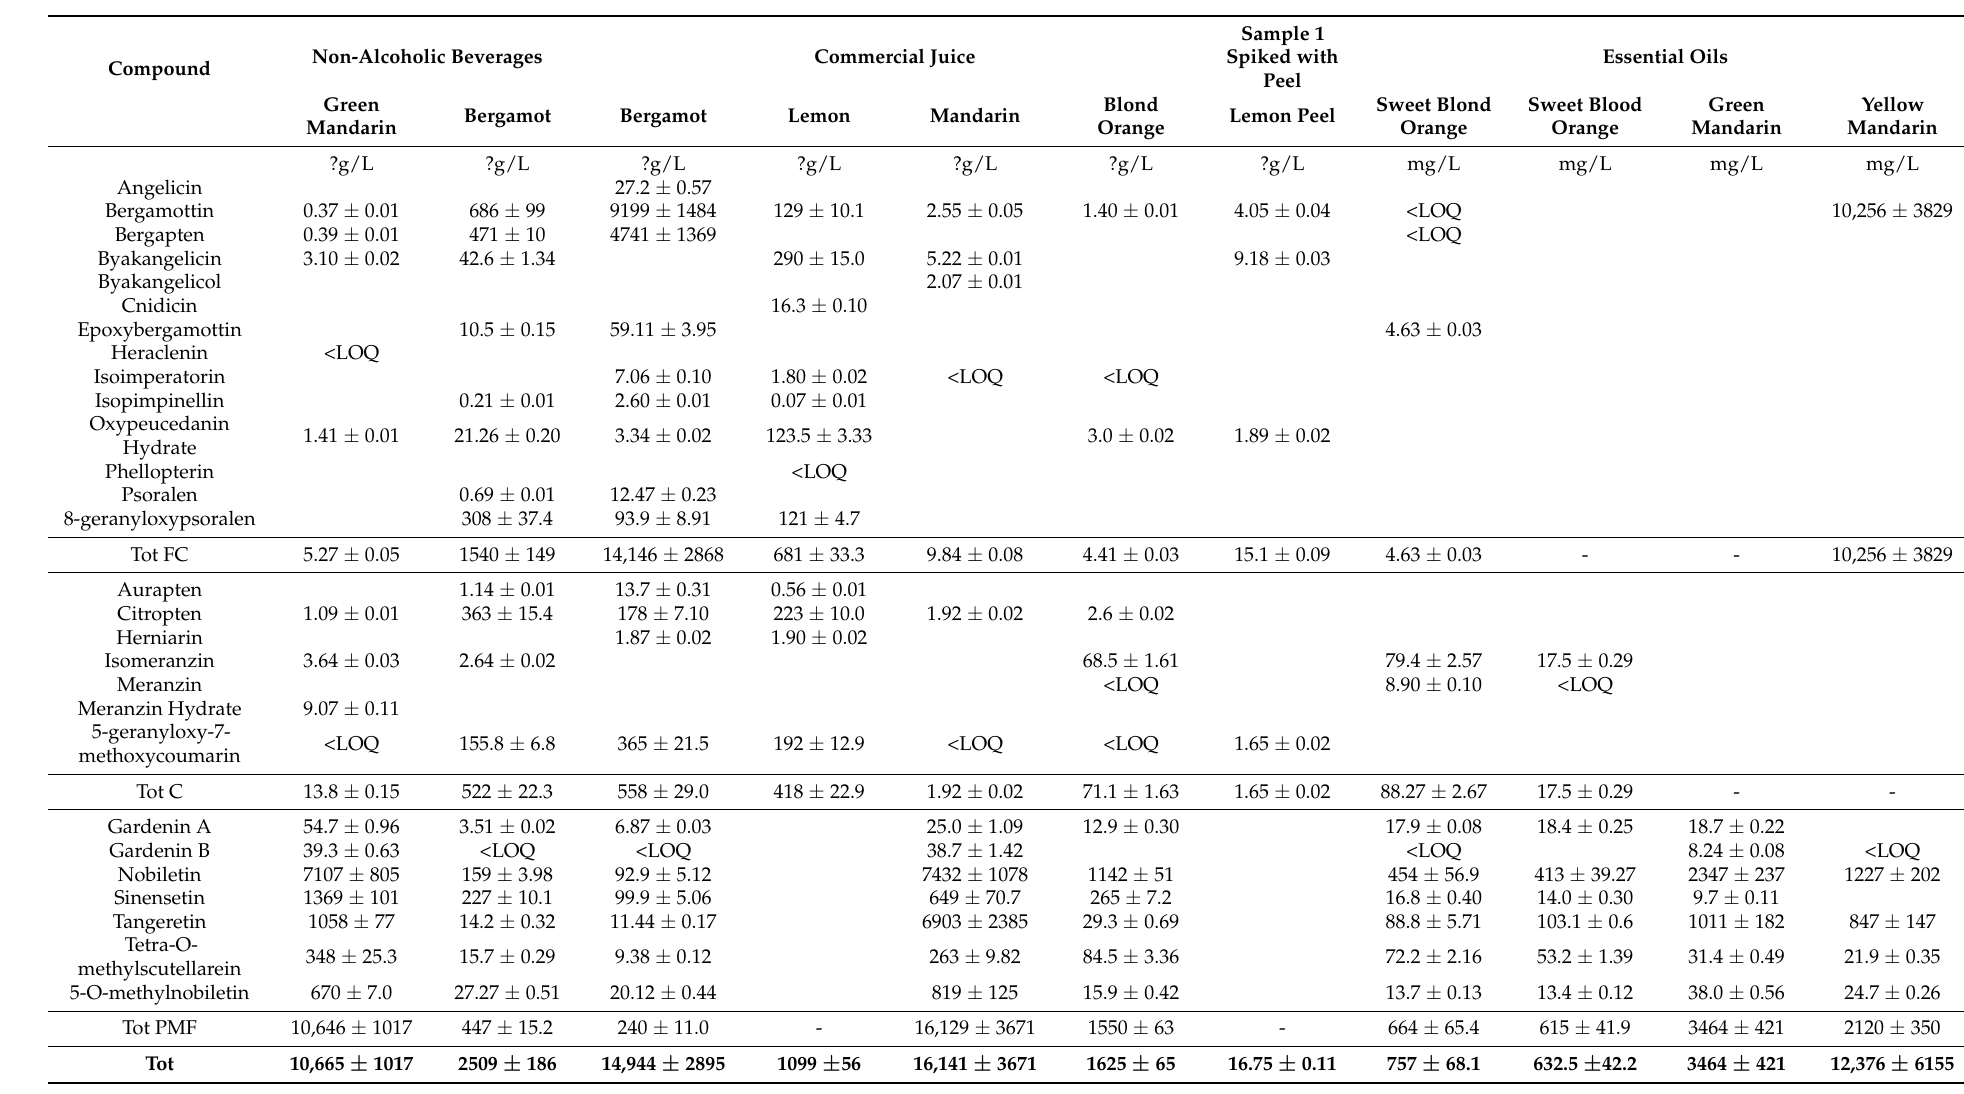
Table 5. Oxygen heterocyclic compounds contained in the samples analysed, expressed in g/L or mg/L ( ± expanded uncertainty) as average of three measurements.